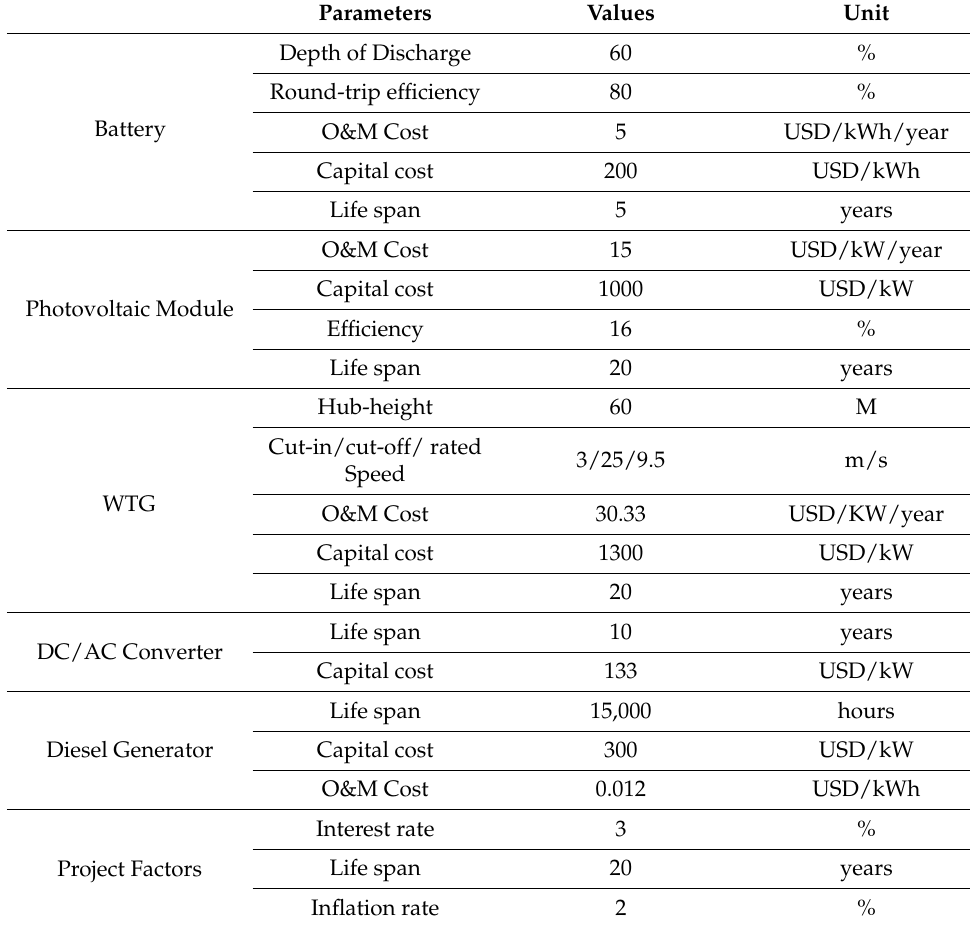
Table 1. Parameters of the HES system.